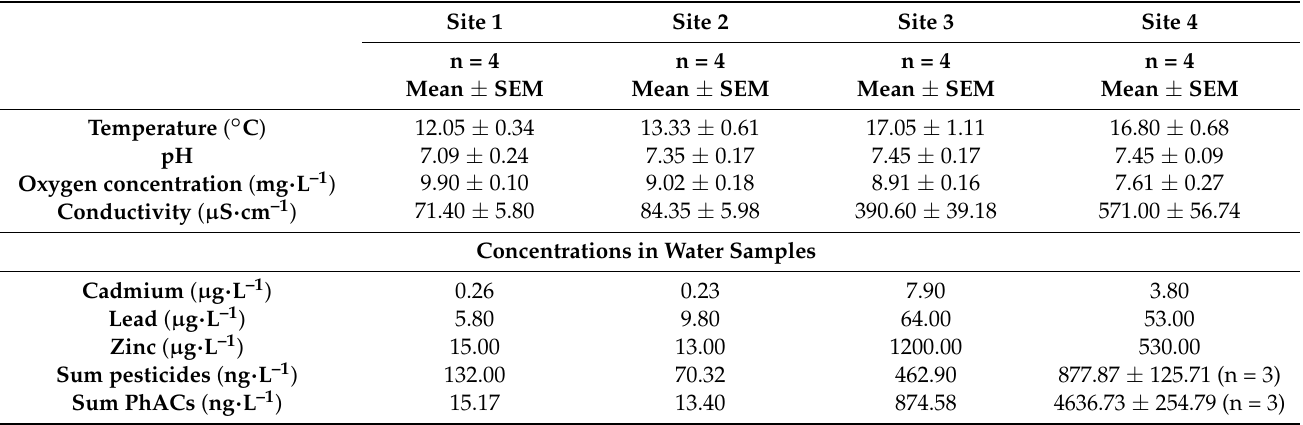
Table 1. Resulted mean physicochemical parameters measured at the given sites and concentrations of metals, pesticides, and active pharmaceutical compounds (PhACs) in water samples taken at these sites.